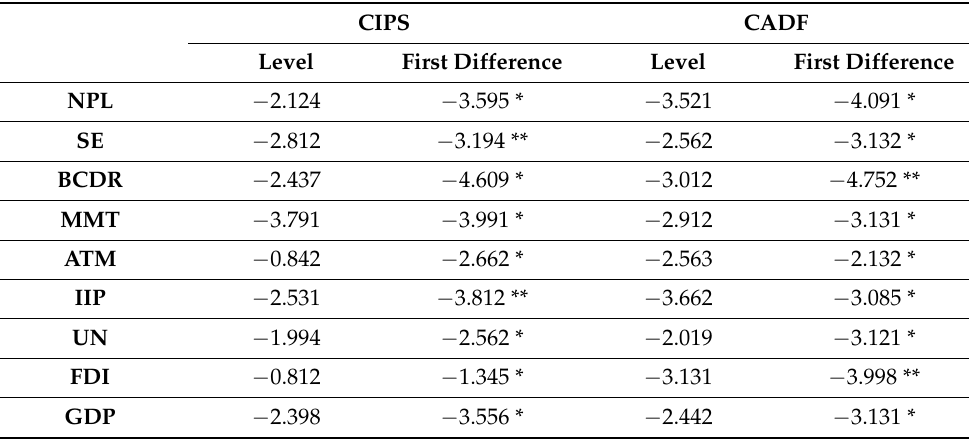
Table 4. Unit root